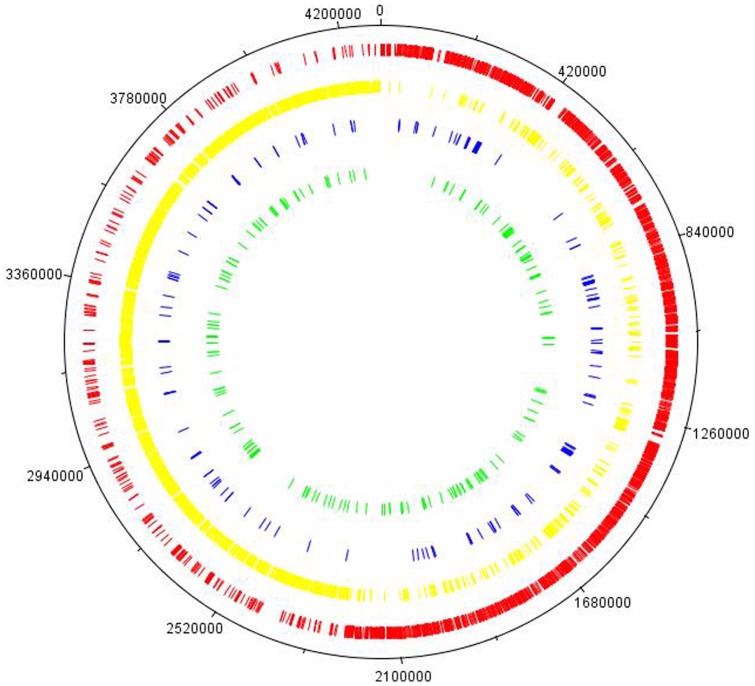
Projection of differentially expressed genes on the Clostridium difficile 630 genome.Those genes showing at least 1.5-fold change with p<0.05 were selected. From outside to inside: Ring 1, molecular clock of C. difficile strain 630 genome; Ring 2 (red), coding DNA sequences of the forward strand of the genome; Ring 3 (yellow), coding DNA sequences(CDS) of the opposite strand of the genome; Ring 4 (blue), genes upregulated at 41°C; Ring 5 (green), genes downregulated at 41°C.